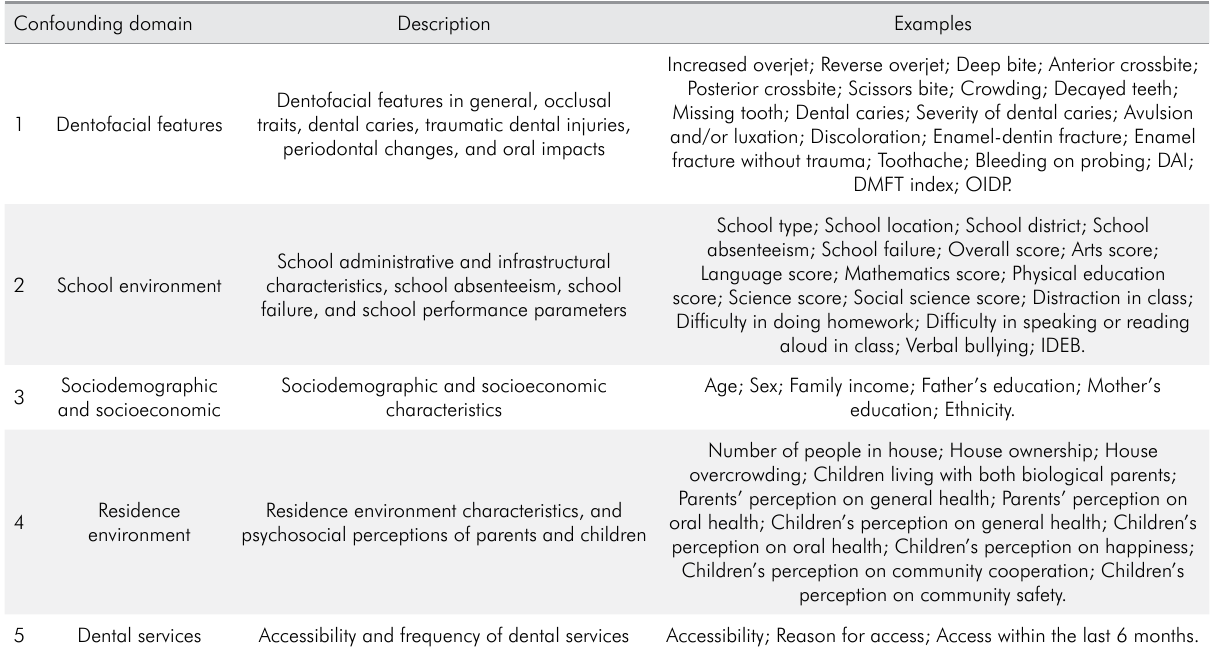
Table 6. Confounding domains identified in selected studies Confounding domain